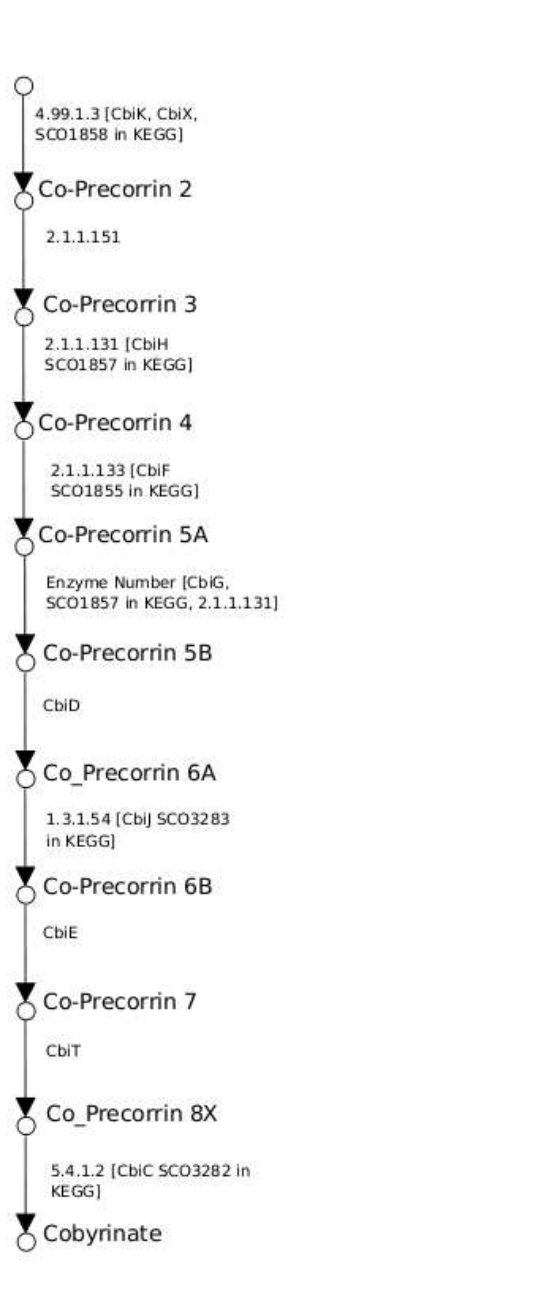
Figure 2: Pathway for sirohydrochlorin to Cob(II)yrinate a,c diamide. Some steps have no associ- ated EC number in the KEGG maps. As only biochemically characterised enzymes are assigned EC numbers, it may be the case that some of the enzymes are theoretical at this